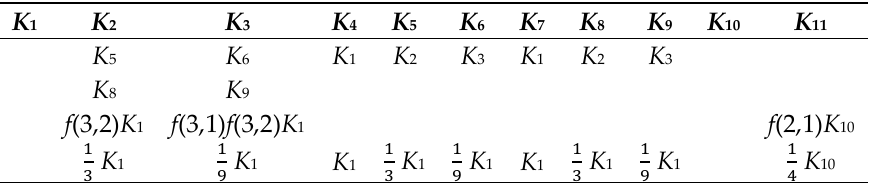
Table 3. Relation between the equilibrium constants defined in Table 1 as a consequence of Langmuirs’s condition and the particle distribution function.